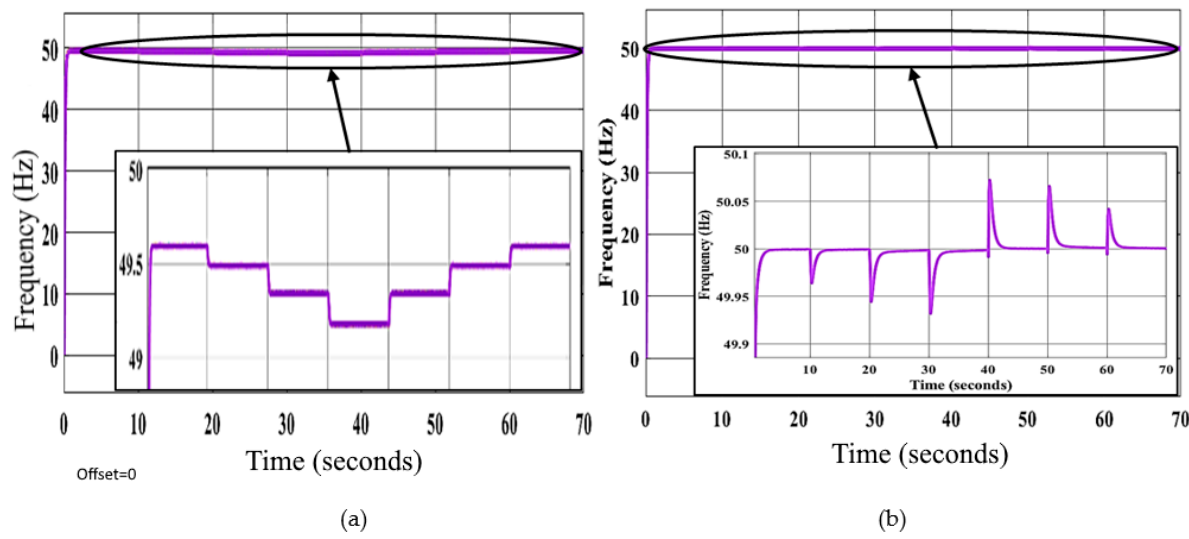
Figure 10. The system frequency response using primary control in ( a ) and with applying GA-based SCUs in ( b ).